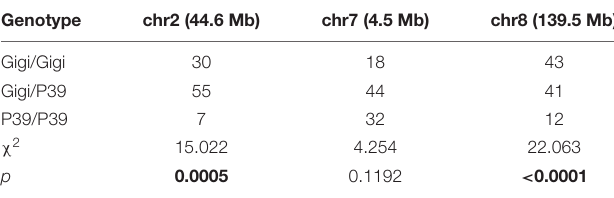
Numbers of plants with specified genotype (rows) at each genomic marker (columns) are displayed. Bottom rows depict chi-square and p-values to analyze significant deviation from Mendelian (1:2:1) expectations. p-values below 0.05 are